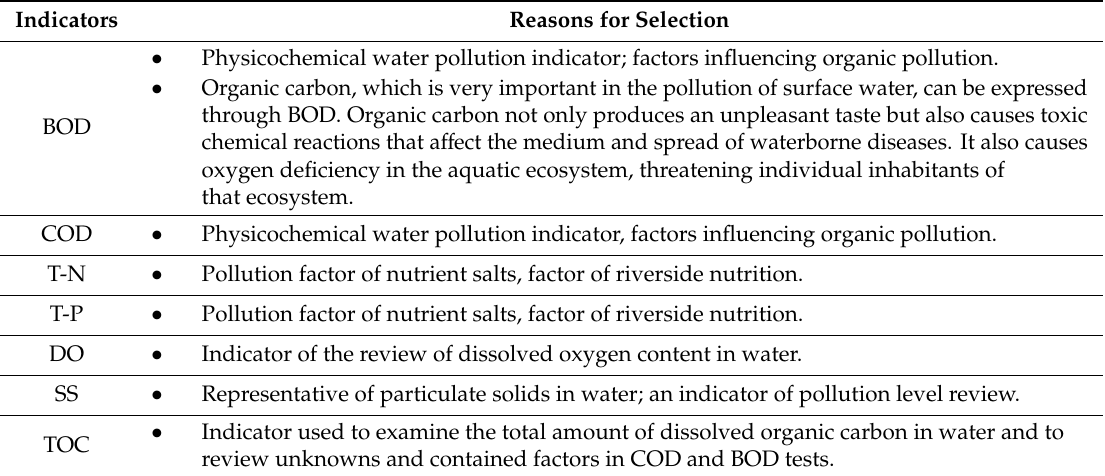
Table 3. Detailed reasons for selecting specific indicators by